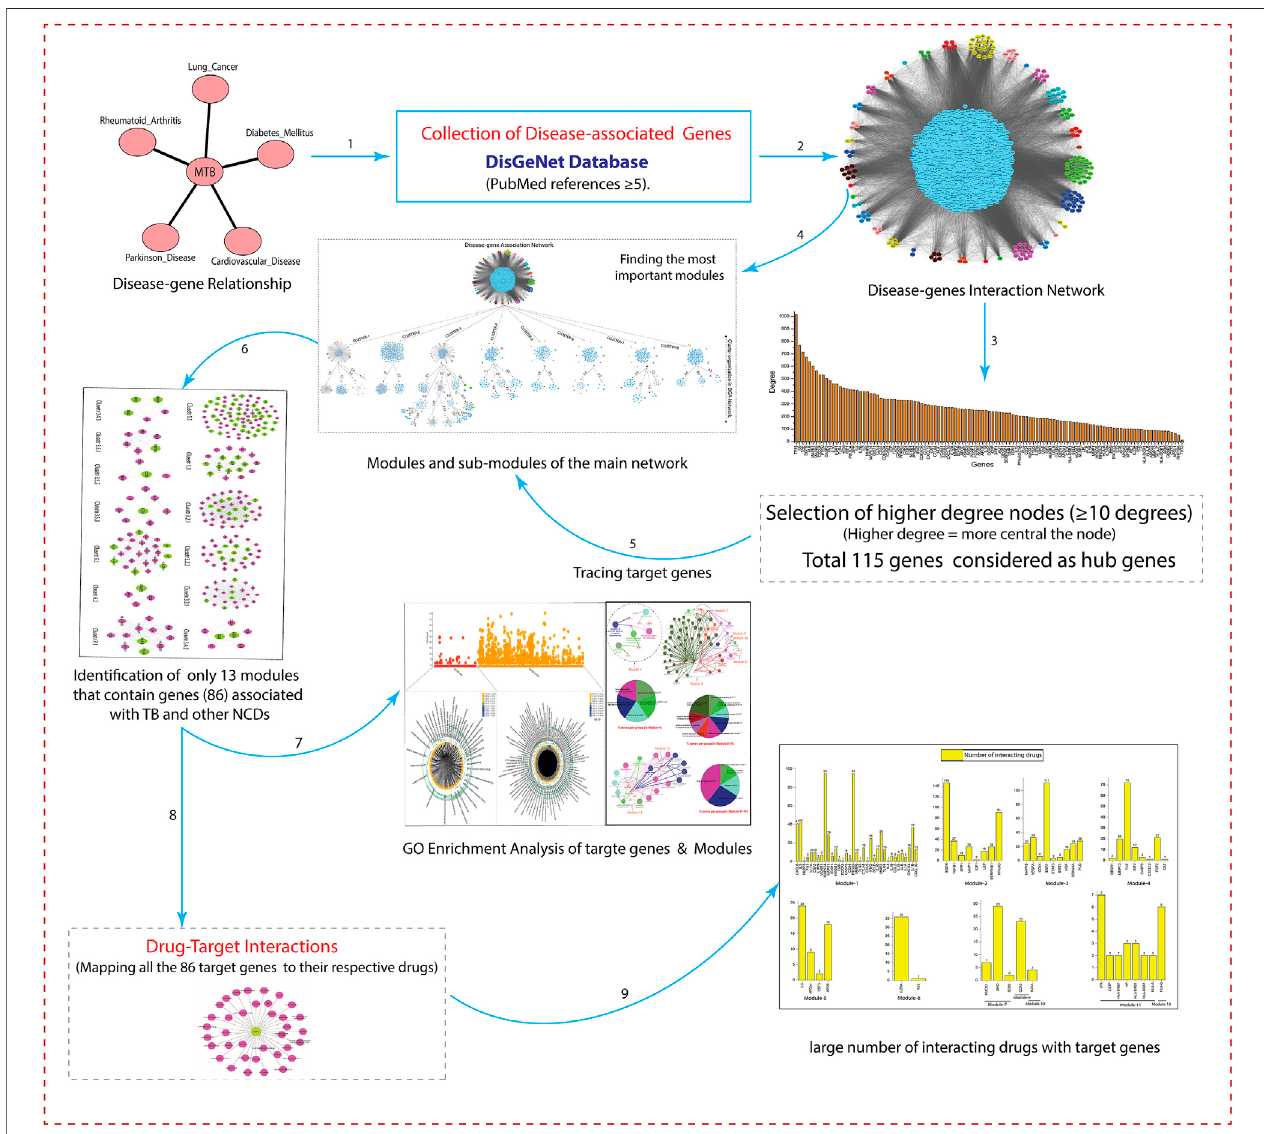
FIGURE 1 | The schematic representation of work fl ow and methodology used in this study.